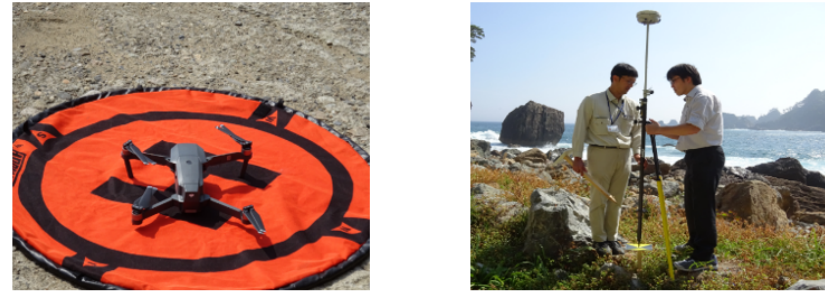
Figure 2. Drone and GNSS Measurement Device.